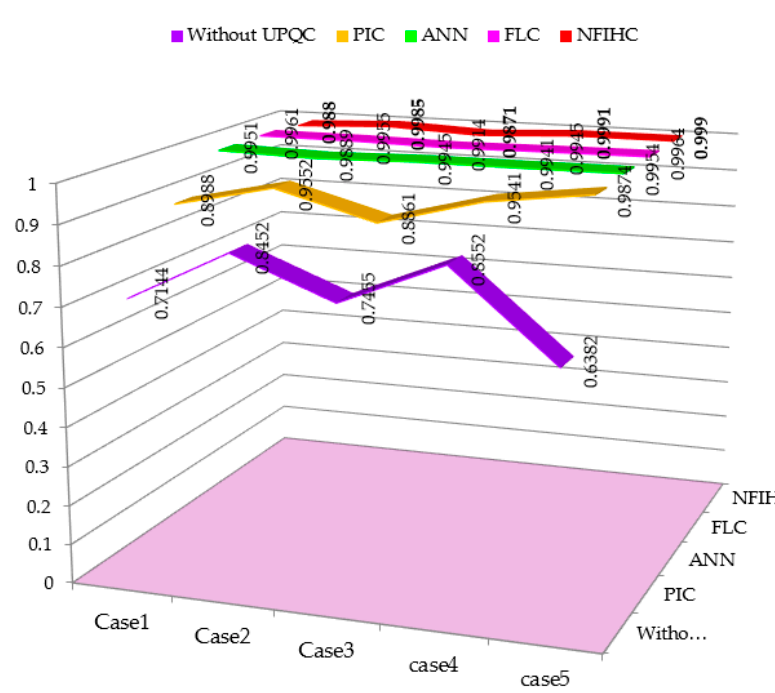
Figure 14. PF Figure 14. PF comparison. Table 5. Case studies considered.